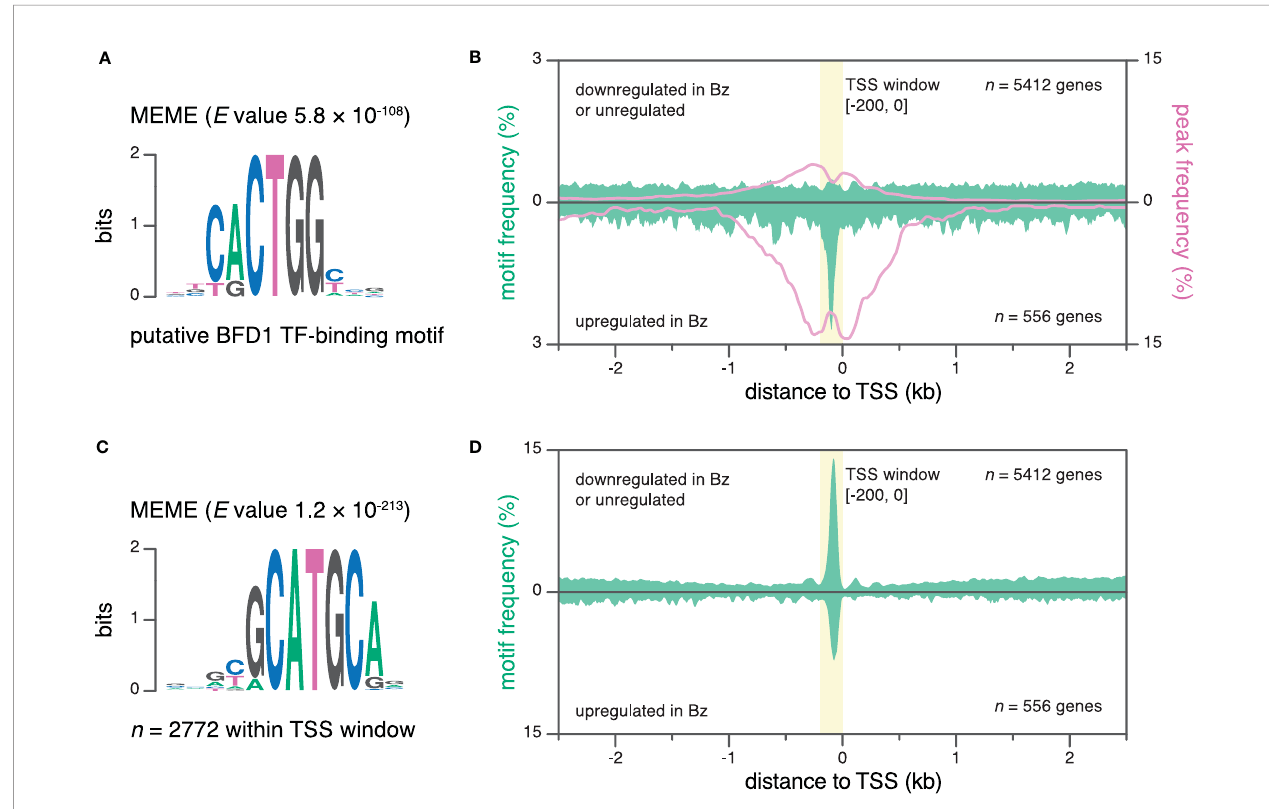
FIGURE 4 | Discovery of new sequence motifs using base-pair-resolution transcription start site (TSS) data. (A) Putative binding motif of the transcription factor BFD1 (Waldman et al., 2020). (B) Frequencies for the putative BFD1 motif (green, left y-axis) and CUT&RUN peaks (magenta, right y-axis) around different TSS subsets. Top, ME49 Tz TSSs of genes that are either downregulated ( ≥ 2-fold change on a log 2 scale) in ME49 Bz or not regulated, as evaluated by RNA-seq. Bottom, ME49 Bz TSSs of genes that are upregulated in ME49 Bz ( ≥ 2-fold change on a log 2 scale). A TSS window (-200 to 0 bp; yellow) captures the peak in motif frequency at TSSs of genes upregulated in ME49 Bz. Data was smoothed using a 40-bp rolling average. (C) The MEME motif (gCATGCa) was signi fi cantly enriched within TSS windows combined from both ME49 Bz and Tz. (D) Mean gCATGCa-motif frequency around different TSS subsets, as in (B)